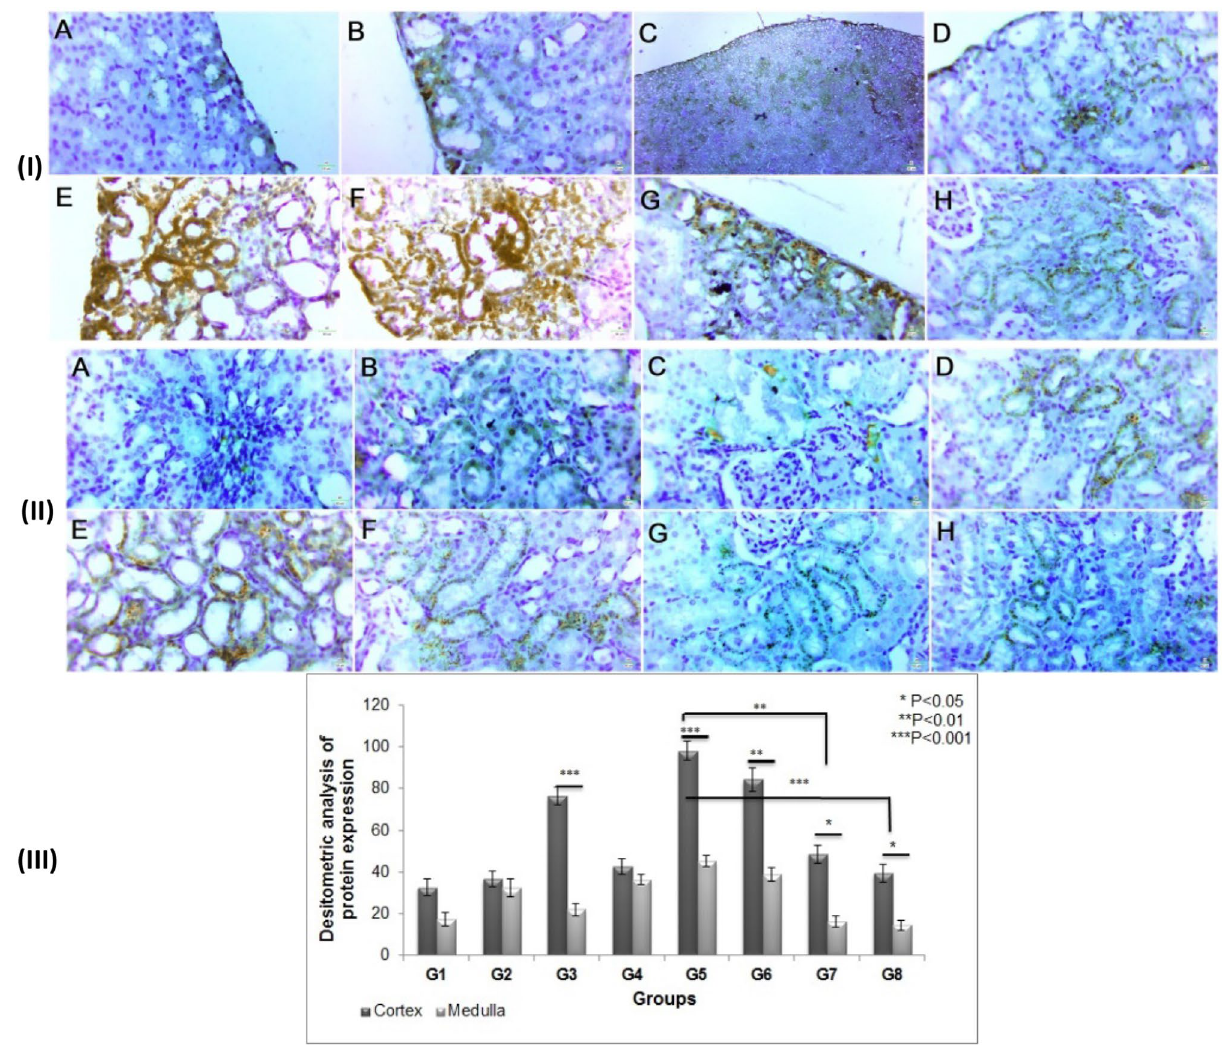
Figure 8. The effect of different treatments on caspase-3 immunoreactivity and densitometry in CDDP- induced nephrotoxicity in all the studied groups. Caspase-3 immunoreactivity evaluations in the cortex ( I ) and the medulla ( II ) of the kidney of rats. ( III ) caspase-3 densitometry immunohistochemistry expression analysis in both cortex and medulla in all studied groups. Caspase-3 expression using immunohistochemical staining in kidney sections: ( A ) the control group, ( B ) the GA group, ( C ) the CMCS group, ( D ) the GA@CMCS group, ( E ) the CDDP group, ( F ) the (CDDP + GA) group, ( G ) the (CDDP + CMCS) group, and ( H ) the (CDDP + GA@ CMCS) group. (Caspase-3 expression, scale bar: 50 um). All data have been presented as mean ± SE. *p < 0.05, **p < 0.01, and ***p < of GA molecules on the surface of CMCS through the covalent linkage between the NH 2 group of CMCS and the COOH group of GA to form an amide bond. On the other hand, no vibrational band was observed in the spectral region distinctive of the absorption of the ester carbonyl group (1700–1800 cm −1 ) 46 , confirming that no ester bond was formed between the OH groups of the CS backbone and the COOH group of GA. Consequently, the grafting of GA on CMCS occurs only through the amide coupling reaction between NH 2 and COOH of CMCS and GA, respectively. In UV–Vis spectra, the red-shift of the GA absorption peak from 264.00 to 270.50 nm, could be attributed to the decrease in energy required for the π → π* and n → π* transitions due to the covalent linkage between CMCS and GA, which is indicative of the successful grafting of GA onto CMCS. In addition, the emer- gence of a new UV peak at 364.00 nm in the spectrum of the GA@CMCS offers further evidence. Another strong proof of the success of GA grafting onto the CMCS surface was provided by the 1 H NMR spectral technique . As shown in Fig. S2 (ESM S1), GA exhibited only a sharp peak at 6.99 ppm attributable to the resonance of phenyl protons 47 . On the other hand, the two peaks observed at δ 3.86 and 1.83 ppm in the NMR spectrum of LMWCS (Fig. S3, ESM S1) could be assigned to the resonance of protons of the glucopyranose unit and the methyl group of the N-acetyl glucosamine unit, respectively, of the CS backbone 20 . The emergence of a new singlet peak in the spectrum of CMCS (Fig. S4, ESM S1) at δ 4.30 ppm equivalent to two protons of a methylene group, is indicative of the success of chloromethylation of LMWCS to CMCS 42 . As for the 1 H NMR spectrum of GA@CMCS (Fig. S5,